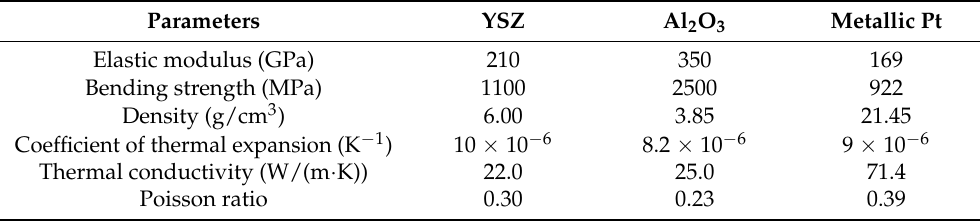
Table 1. Physical parameter settings of YSZ, Al 2 O 3 , and Pt heating circuit for numerical simulation. Parameters YSZ Al 2 O 3 Metallic Pt Elastic modulus (GPa) 210 350 169 Bending strength (MPa)